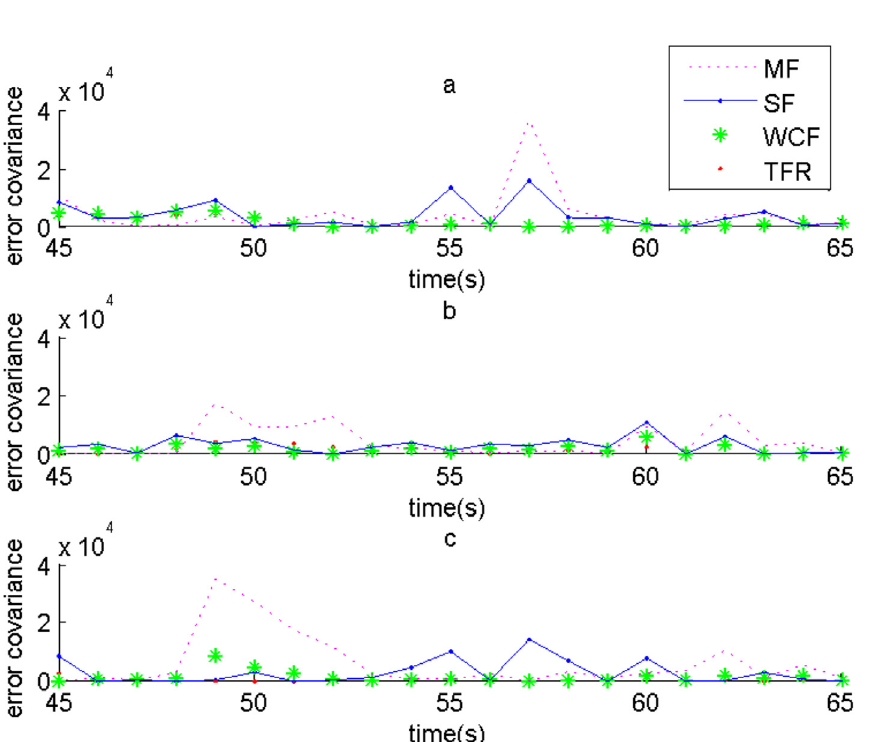
Fig 4. Comparisons of error covariance among MF, SF, WCF and TFR at the inflection points of target1. (a) In x-axis, (b) In y-axis, and (c) In